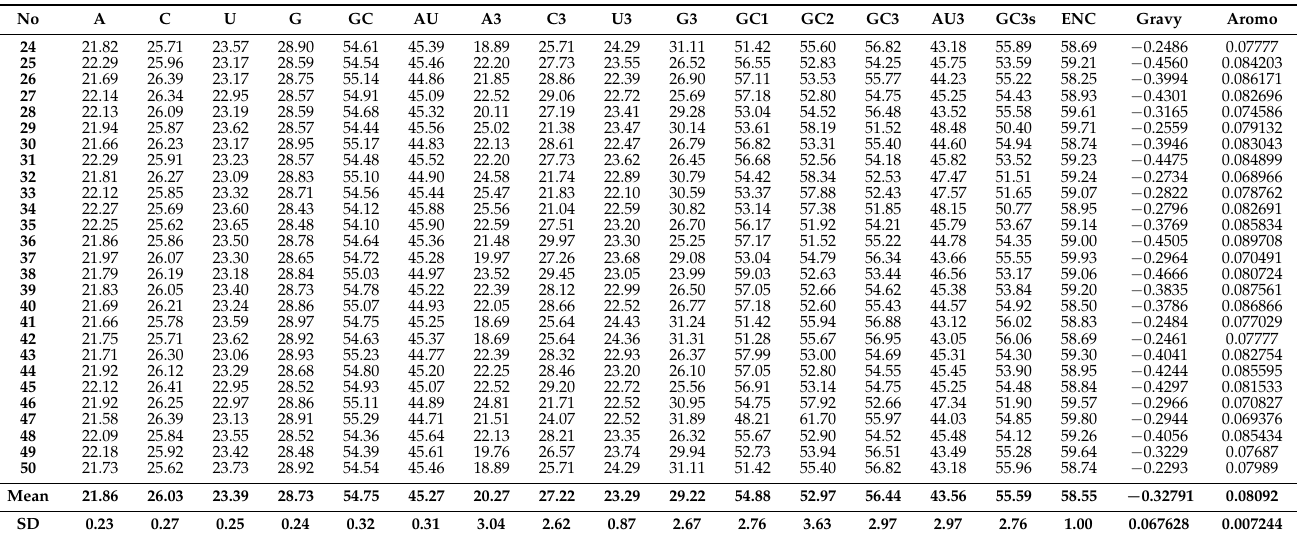
ENC represents the effective number of codons. GC1 represents the G + C content at the first position of codons. GC2 represents the G + C content at the second position of codons. GC3 represents the G + C content at the third positions of codons. AU3 represents the A + U content at the third positions of codons. Gravy represents the hydrophobicity of protein. ARO represents the aromaticity of protein.